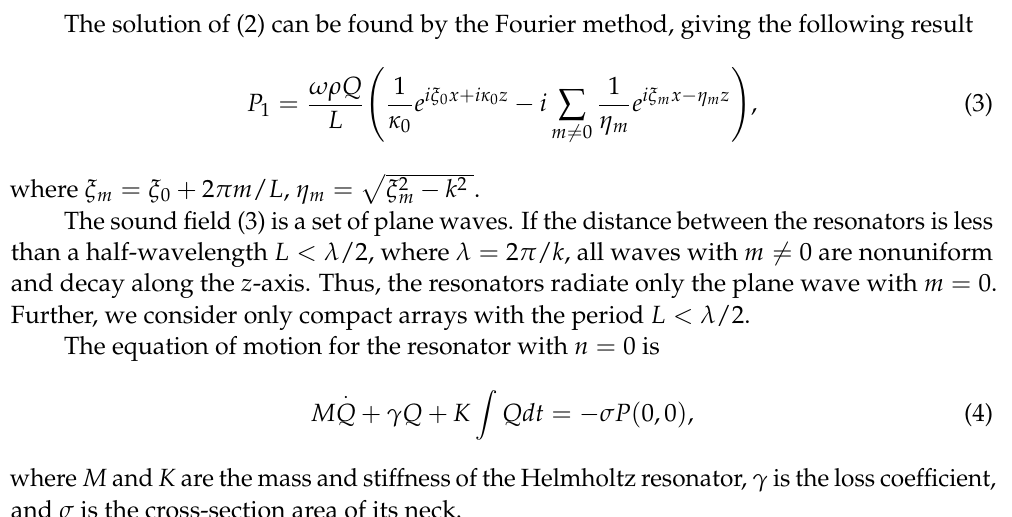
Figure 1. A surface with an array of Helmholtz resonators.